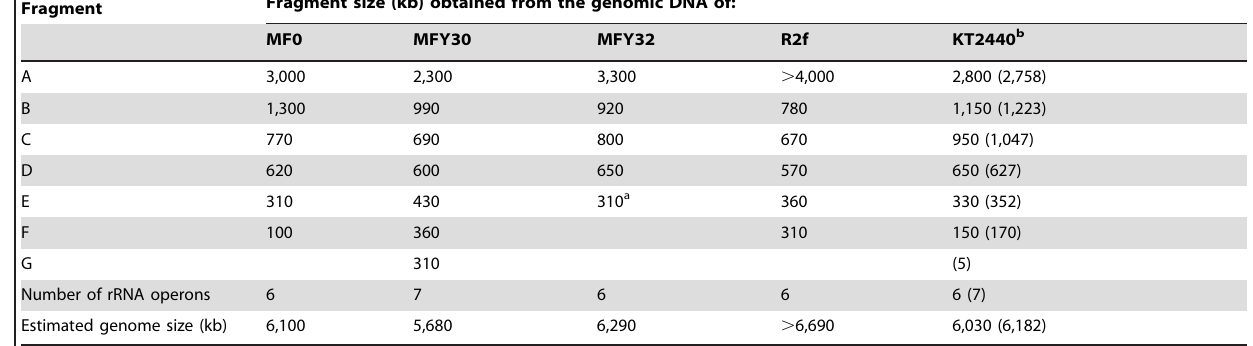
Table 2. Sizes of I- Ceu I fragments of the four Pseudomonas sp.